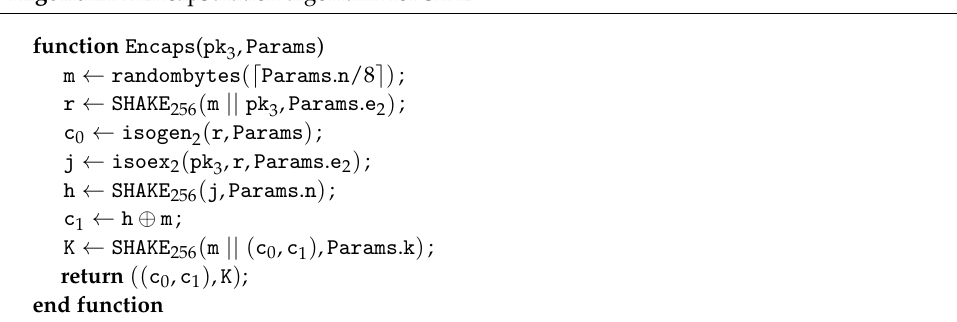
Algorithm 2 Encapsulation algorithm for SIKE.